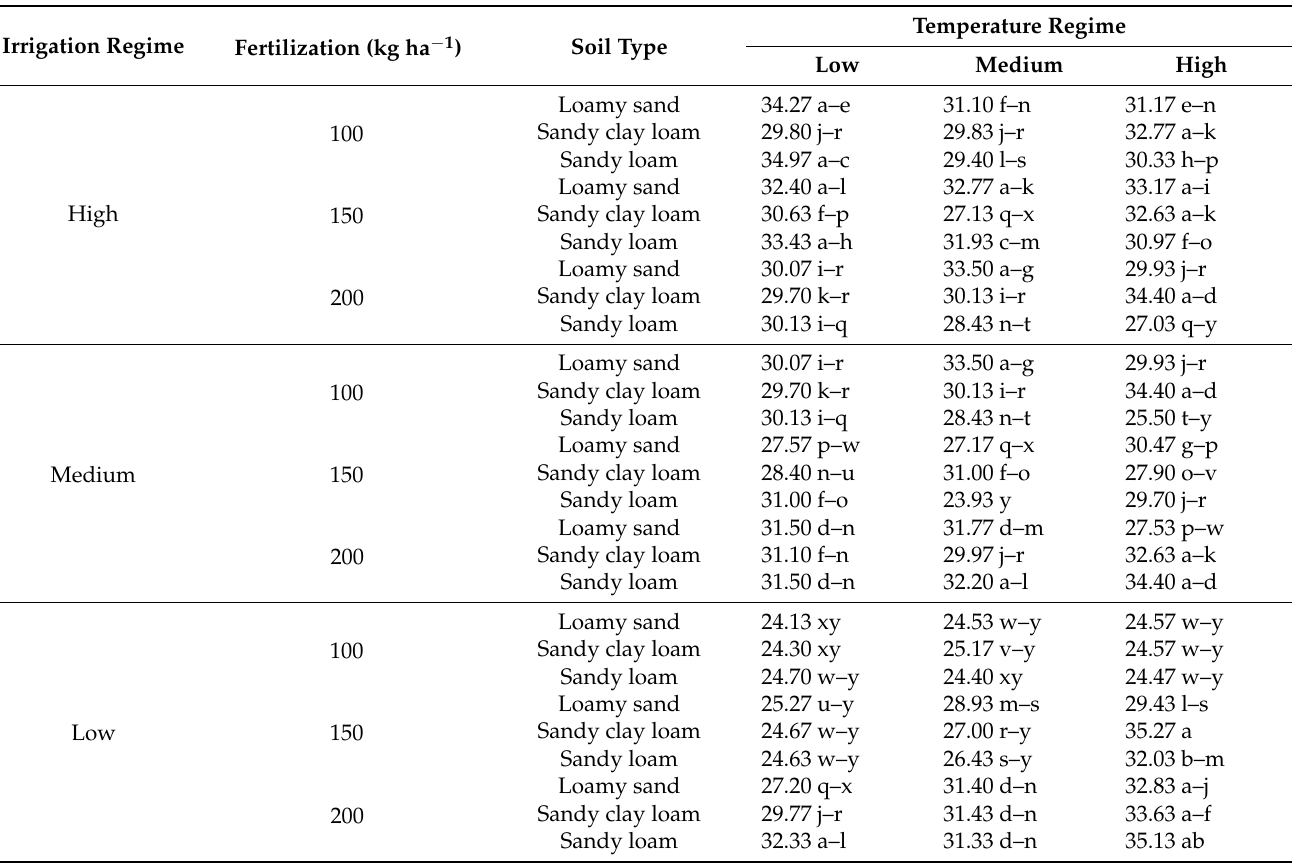
Table 4. Interactive effect of air temperature and irrigation regimes, nitrogen fertilizer application, and soil type on chlorophyll content (SPAD).